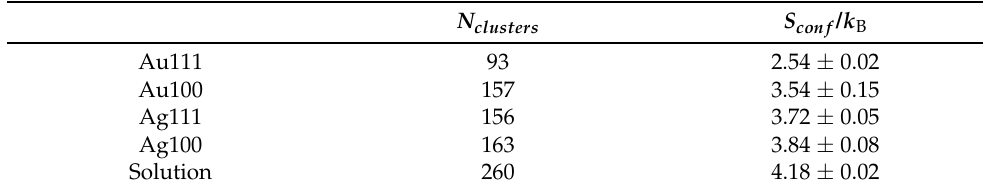
Table 3. Number of clusters and conformational entropy determined from cluster analysis over the last 100 ns of